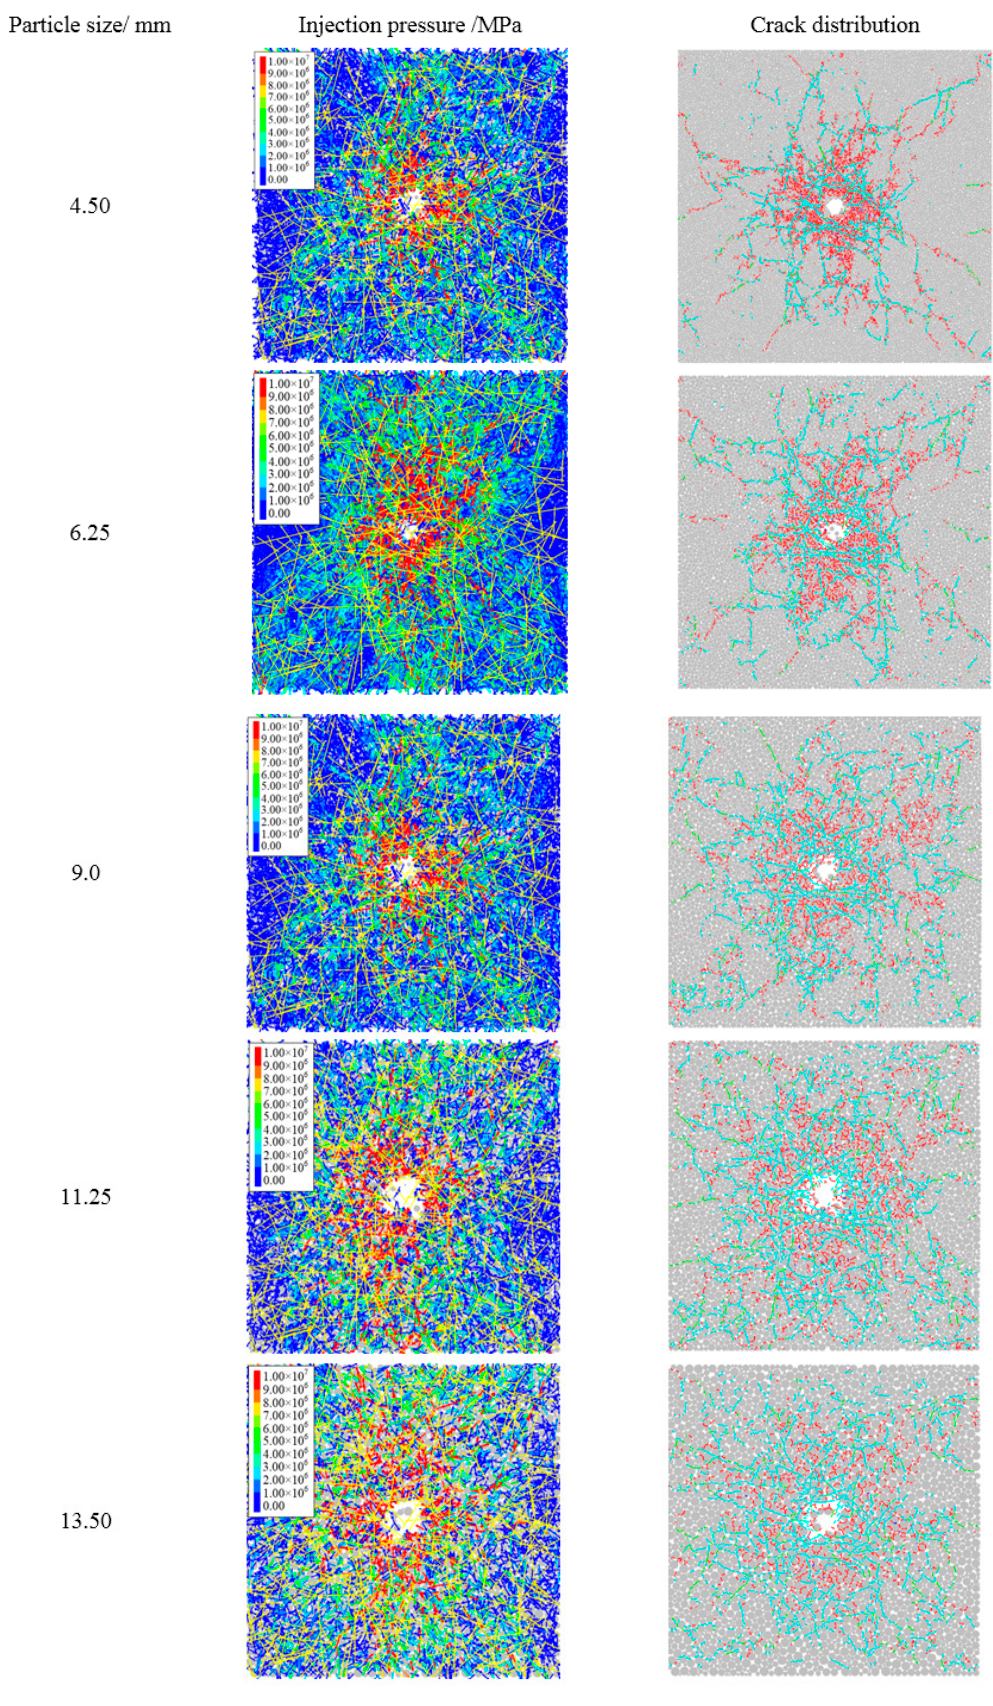
Figure 30. Change of injection pressure and crack distribution with particle size when NF density is 48/m and S H : S h = 10:5.